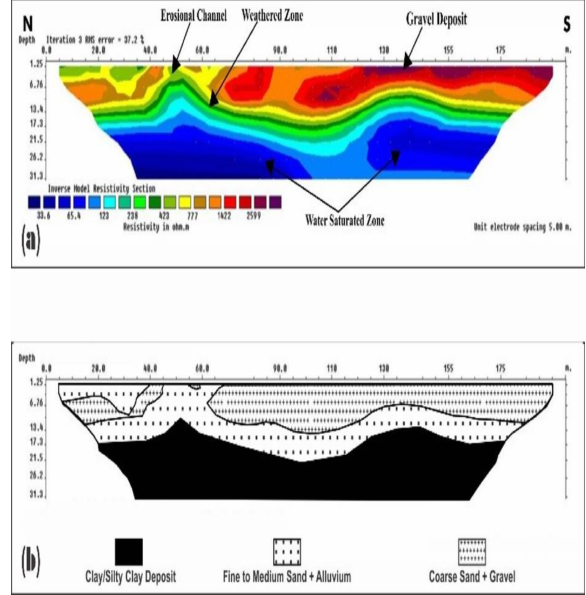
Fig. 9. (a) Profile 8 electrical resistivity tomography; (b) Geologic cross-section interpreted from the resistivity model within a sequence of horizontal sedimentary sequence (see Fig.